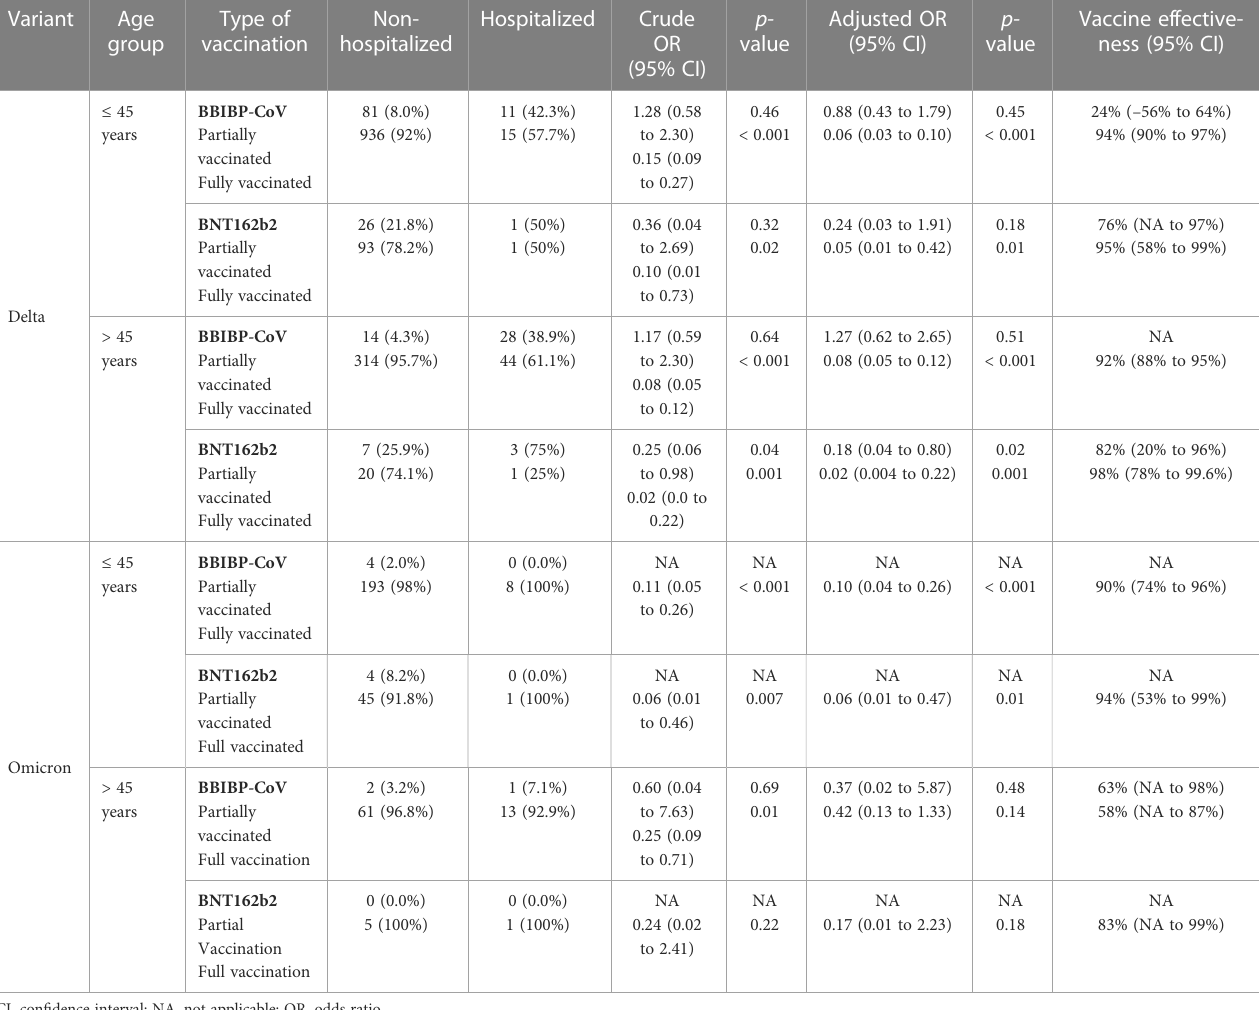
TABLE 3 Estimated vaccine effectiveness against the variant of concern (either the Delta or Omicron variant), strati fi ed by age group ( ≤ 45 years; > 45 years), and analyzed by type of vaccination (BBIBO-CoV) and vaccination status (BNT162b2).